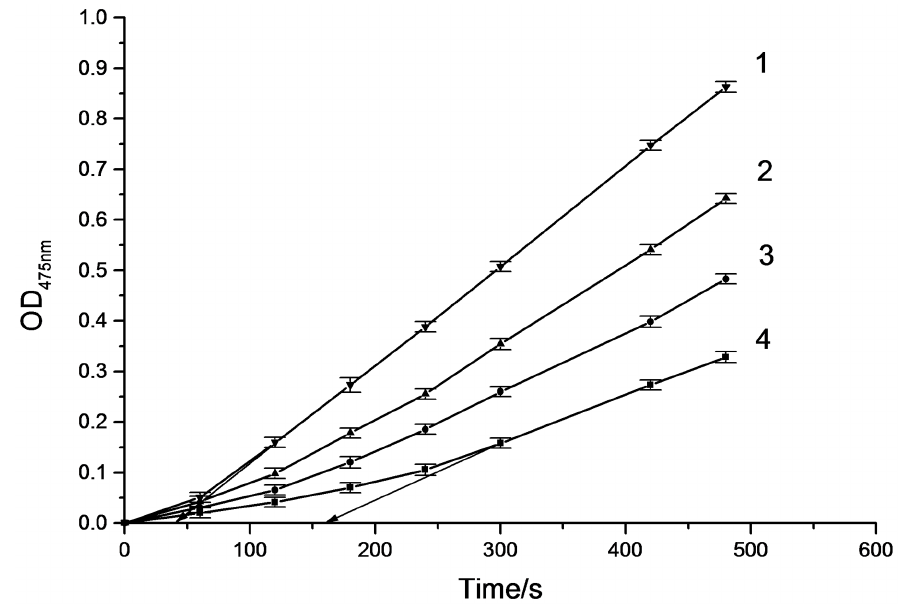
Figure 1. Progress curves for the inhibition of monophenolase of mushroom tyrosinase by a -arbutin at 30 6 C. The reaction media (3.0 mL) contained 0.5 mM L-tyrosine in 50 mM phosphate buffer (pH 6.8), the indicated concentration of a -arbutin, and mushroom tyrosinase (20 m g/mL). The concentrations of a -arbutin for curves 1 , 4 were 0, 1.67, 3.34, 4.18 mmol ? L 2 1 . The reaction was started by the addition of the enzyme.